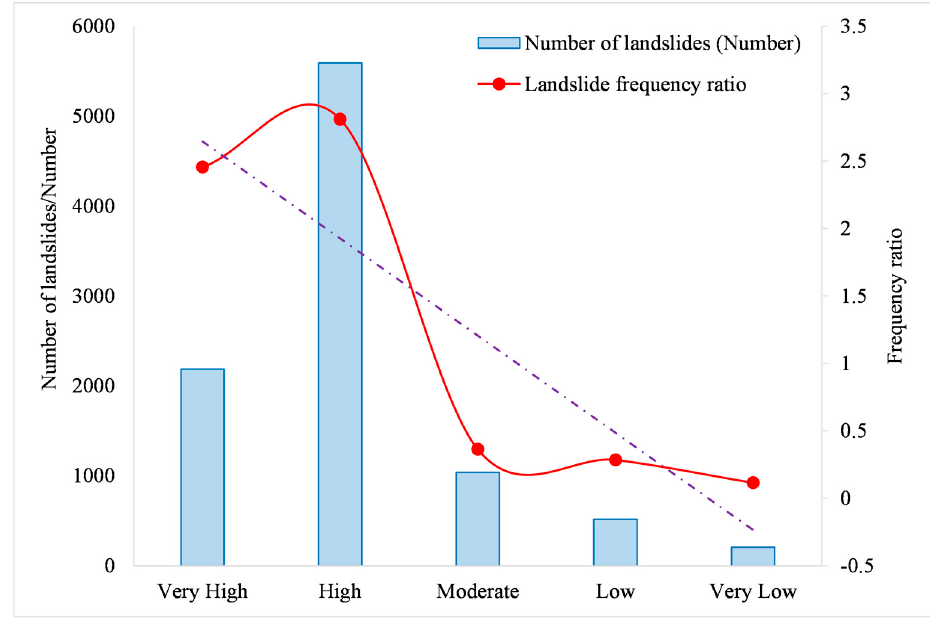
Figure 15. Regional statistics of landslide susceptibility.